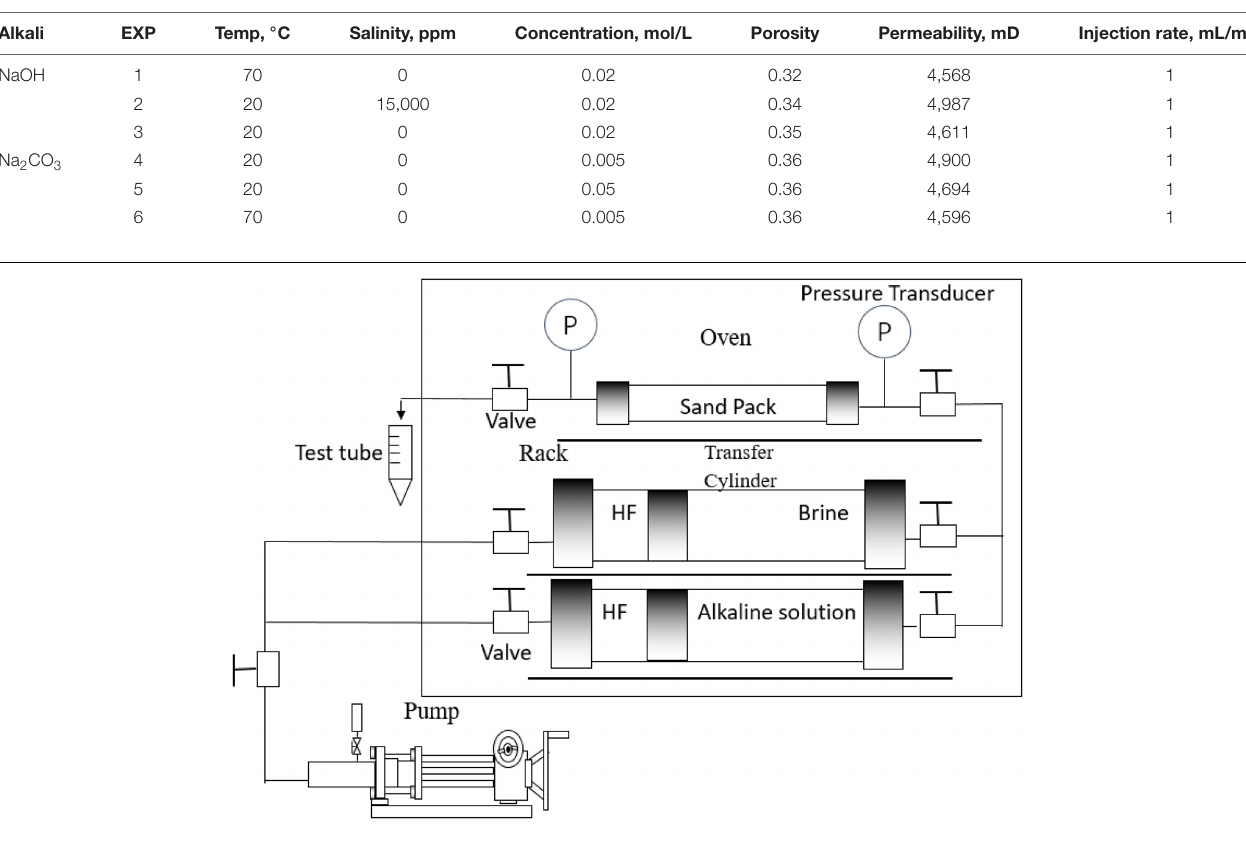
into the water phase as demonstrated by its crystal-clear water phase effluent in Figure 12B . After 0.23 PV of NaOH injection, the pressure at the injection end started to rebuild ( Figure 11C ) which indicates the formation of high viscous oil emulsion with possible wettability reversal inside of the porous media